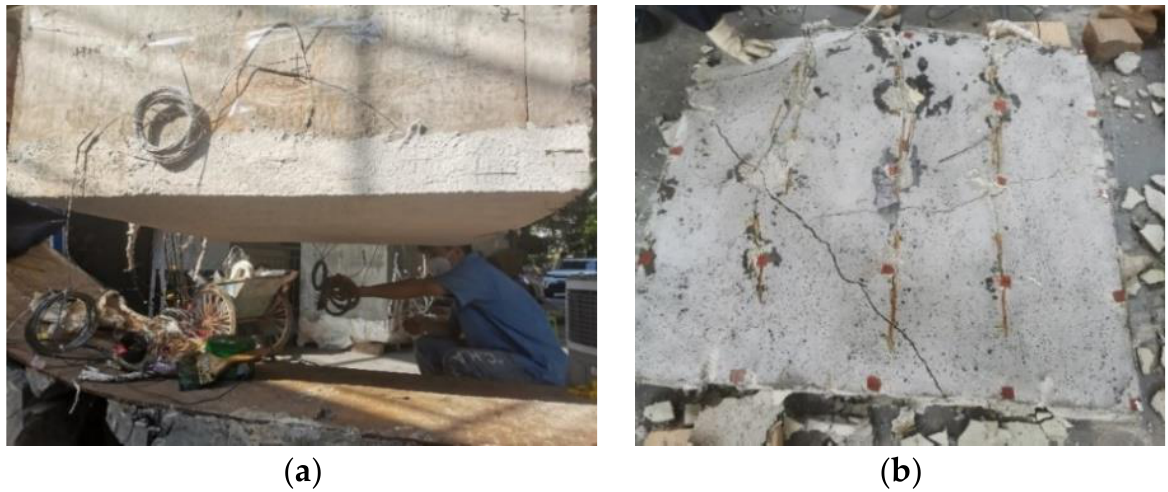
Figure 14. Diagrams of the second fireproof coating insulation test. ( a ) Laying diagram of the fire- proof coating after improvement; ( b ) overall shedding of the fireproof coating.